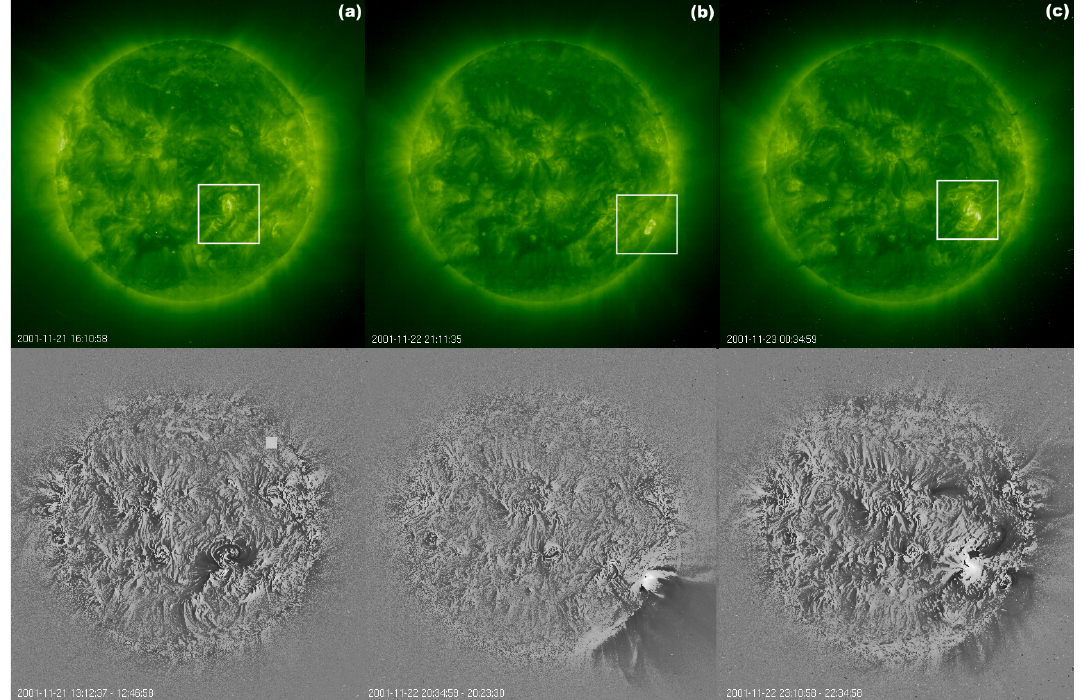
Fig. 2. EIT images of the post eruptive arcades (top panels) and coronal dimmings (bottom panels) corresponding to the three eruptions in November 2001. The lower panels show difference images. (a) CME from 21 November (DOY 325), (b) first CME from 22 November (DOY 326) and (c) second CME from 22